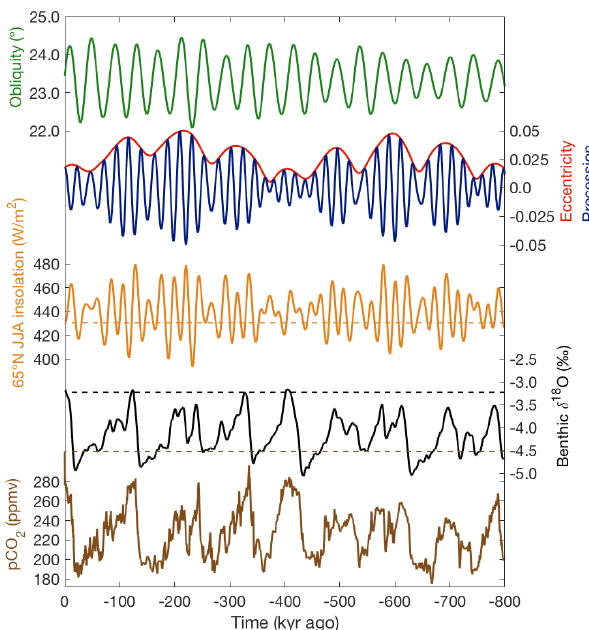
Figure 1. Earth’s orbital parameters (obliquity, eccentricity, and precession) and the resulting Northern Hemisphere summer insola- tion (Laskar et al., 2004), benthic δ 18 O (Lisiecki and Raymo, 2005), and ice-core CO 2 (Bereiter et al., 2015) during the past